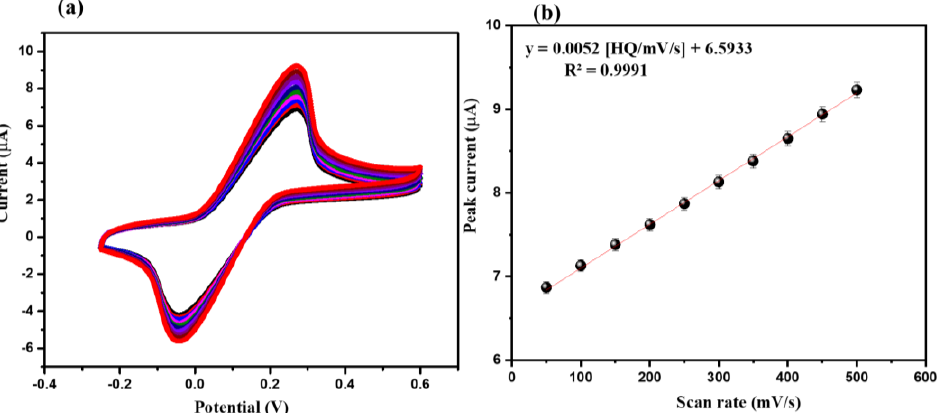
Figure 6. CVs ( a ) of CeO 2 /GCE in presence of 15 µM HQ in 0.1 M PBS (pH = 7.0) at different applied scan rates (50, 100, 150, 200, 250, 300, 350, 400, 450, and 500 mV/s). Calibration curve of peak current versus scan rate ( b ).